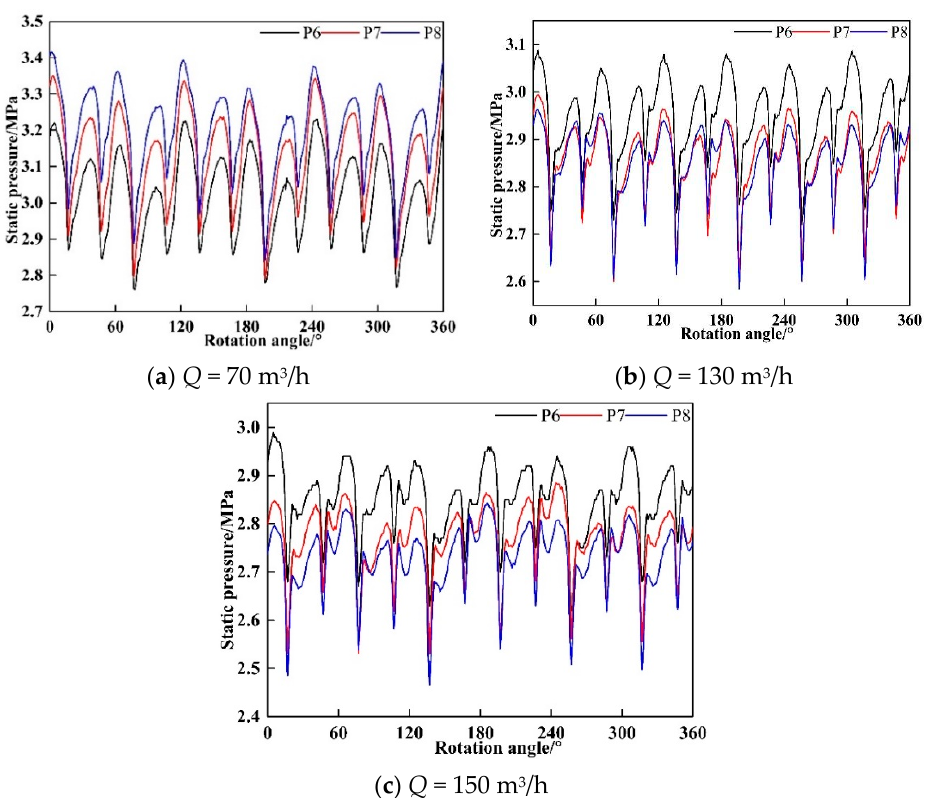
Figure 11. Pressure fluctuations at various monitoring points under different flow conditions.